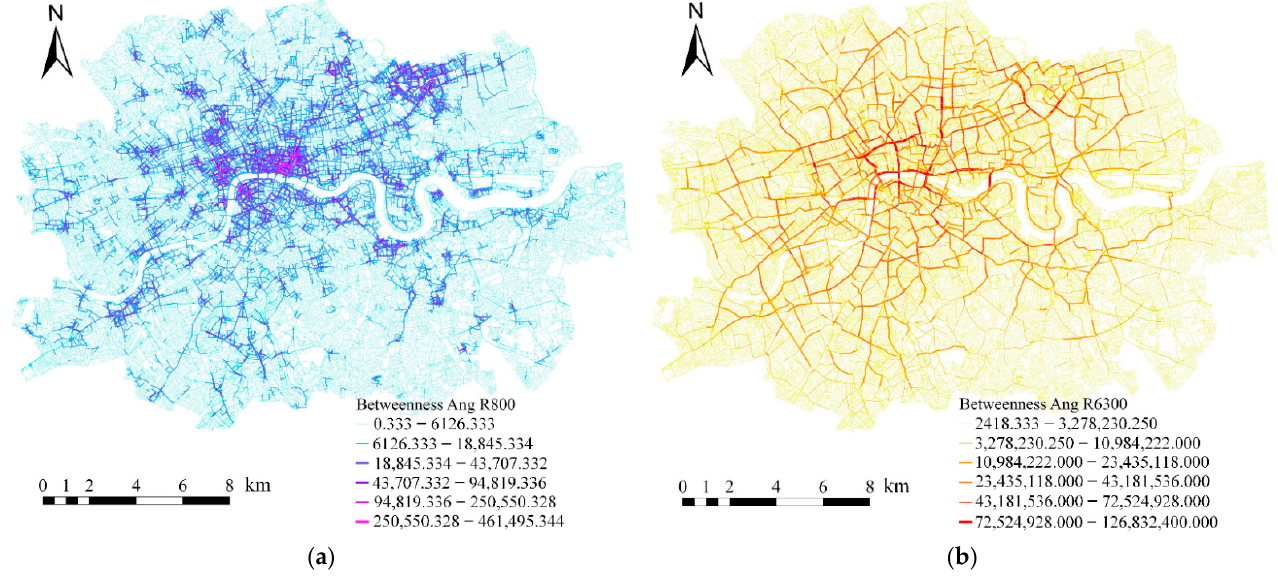
Figure 11. The sDNA space syntax analysis. ( a ) with an 800 m radius; ( b ) with a 6300 m